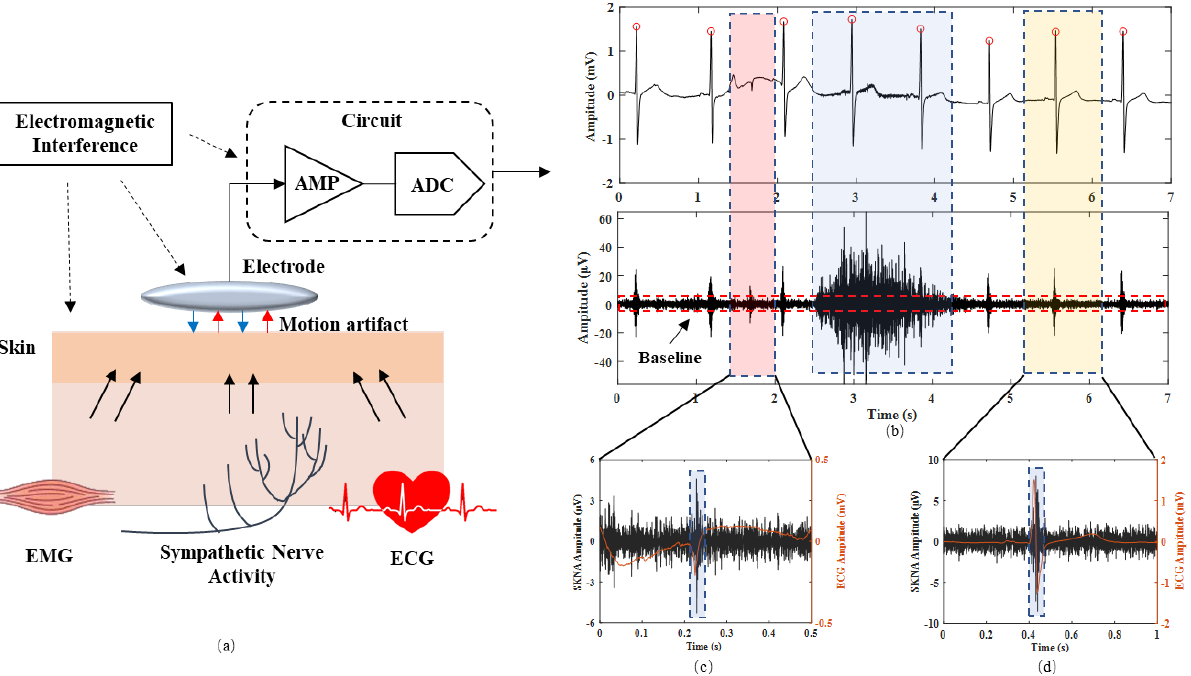
Figure 1. ( a ) The chain of SKNA signal transmission and acquisition. ( b ) Representative